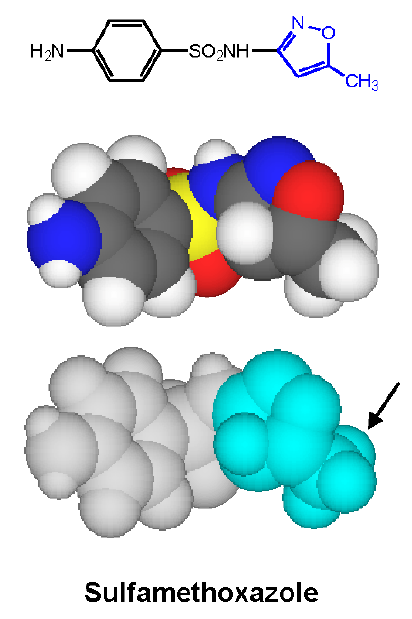
Figure 10. Two- and three-dimensional structures of sulfamethoxazole with the 5-methyl- 3-isoxazolyl IgE-antibody-binding group highlighted (in blue). An important structural feature for recognition by antibody is the methyl substituent (arrowed) β to the point of attachment of the isoxazolyl ring to the N 1 nitrogen